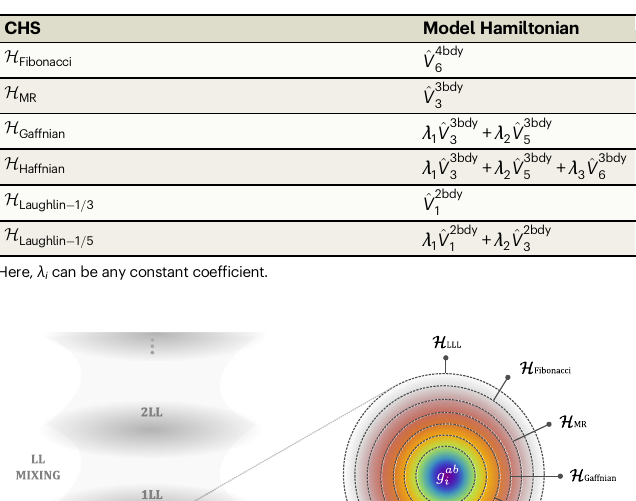
Table 2 | The CHSs are de fi ned as the null spaces of the cor- responding model Hamiltonians